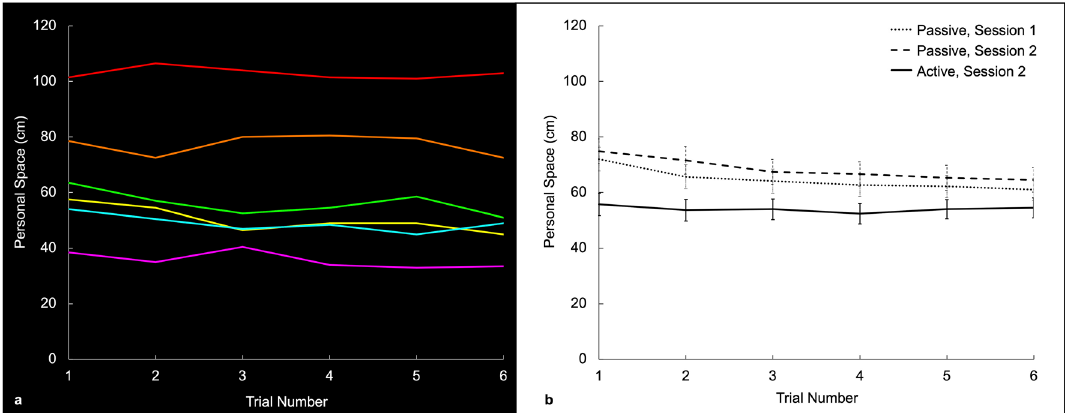
Figure 3. Measurements of personal space size are highly reliable within subjects, but vary across subjects. ( a ) Examples of multiple measurements of personal space size, from six subjects, using the passive Stop Distance Procedure (SDP). Data from each subject is shown in a given unique color, arbitrarily chosen for each subject. The SDP values of personal space size remained quite stable across the six trials for each individual subject. ( b ) Group-averaged personal space size (n = 30), measured using the passive SDP (see the dotted line (Session 1) and the dashed line (Session 2, occurring 2–3 days later)), and using the active version of the SDP (see the solid line; Session 2). Again, these group-averaged SDP data show that personal space size is stable over time, and measurements collected using the passive SDP are consistently larger than those collected using the active SDP. Error bars represent one standard error in each